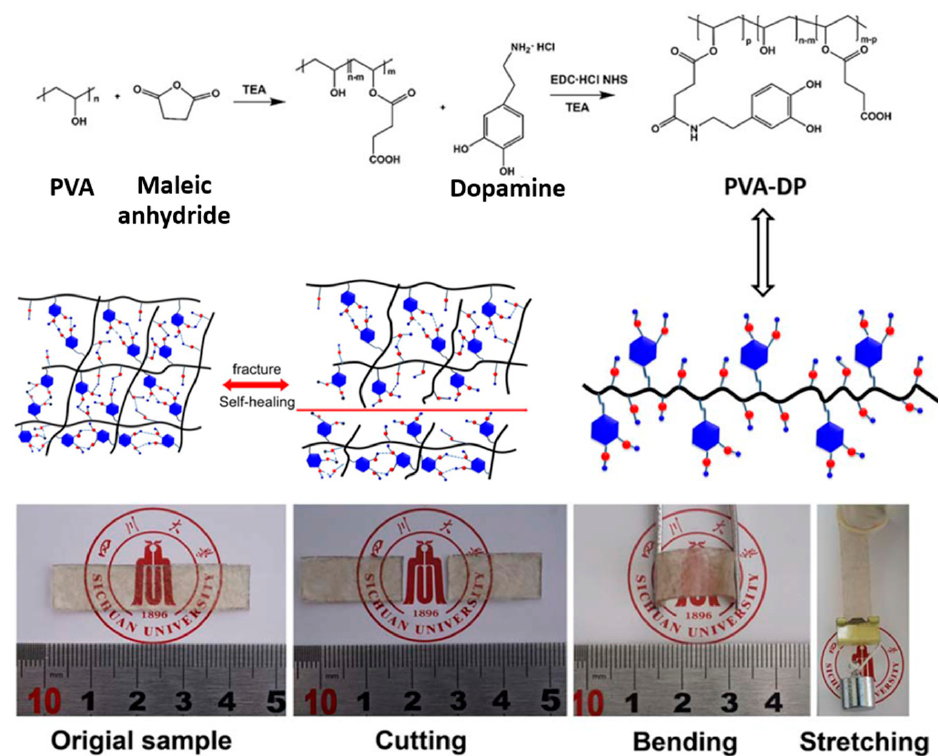
Figure 11. The network formation and self-healing process of the modified poly(vinyl alcohol) elastomer [95]. Adapted from [95], with permission from John Wiley and Sons.